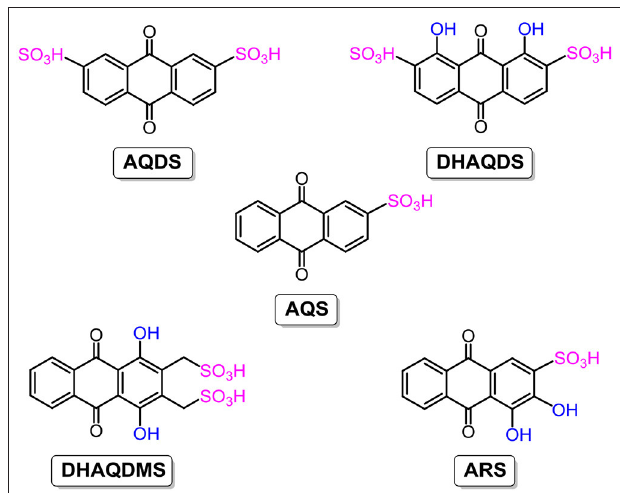
FIGURE 6 | Molecular structures of anthraquinone derivatives for acidic aqueous